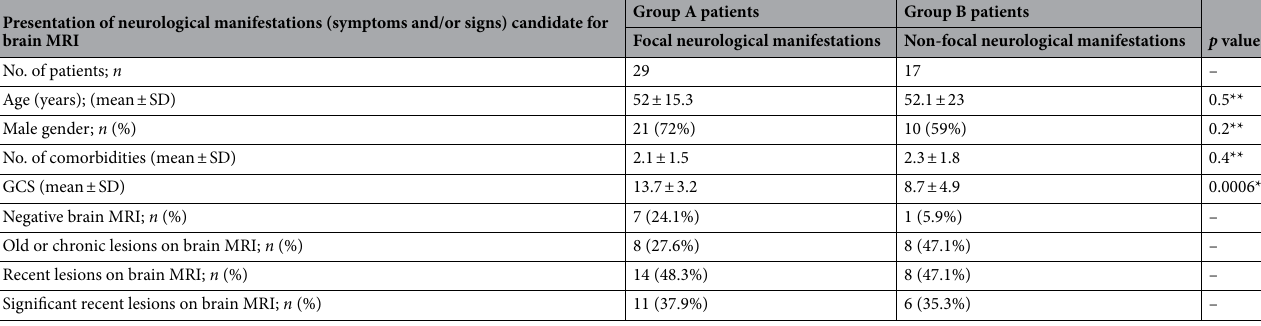
Table 1. Number of negative brain MRIs and characteristics of group A and B patients with RT-proved SARS-CoV-2 pneumonia, presented with neurological manifestations. *Significant correlation ( p ≤ 0.05). **No significant correlation ( p > 0.05).